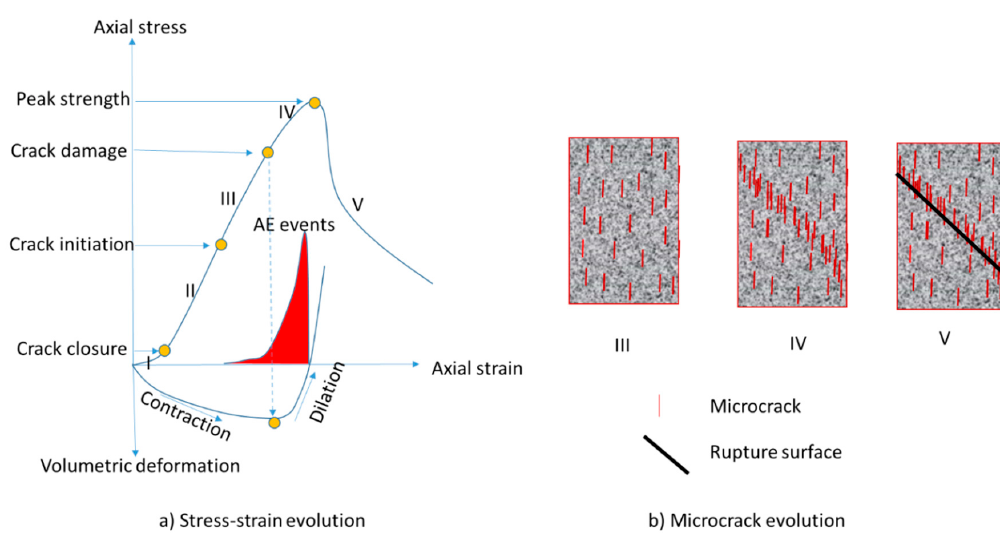
Figure 1. Stages in the progressive failure of intact rock specimens subjected to compressive loading (adapted from [27,28,31]). ( a ) stress-strain evolution: cracks start to initiate at the crack initiation level accompanied by permanent strain. The crack damage is the true strength of the sample. The acoustic emission counts substantially increase after the crack damage level. ( b ) microcrack evolution: the crack formation, coalescence and formation of macrofracture are illustrated at different loading stages.